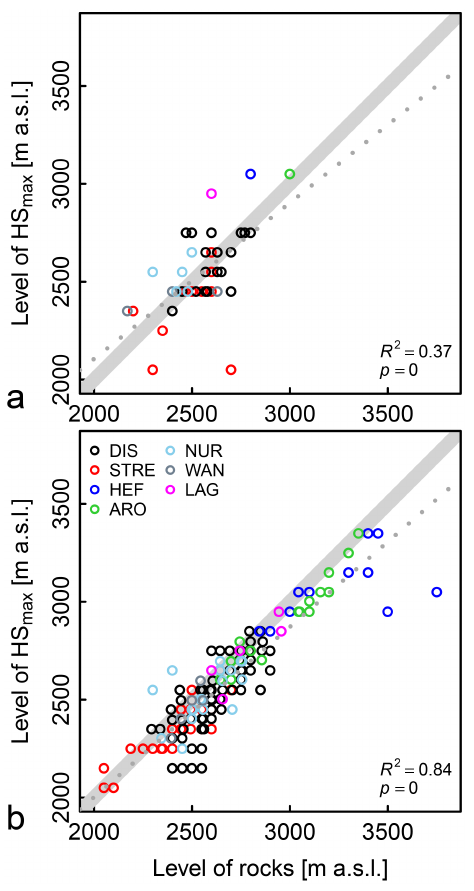
Figure 9. Level of rocks versus level of the maximum of the elevation–snow depth relationship for the sub-catchments (a) and the transects (b) . The grey shaded area illustrates the 1:1 line ( ± 50m) and the dashed line the linear fit of the merged